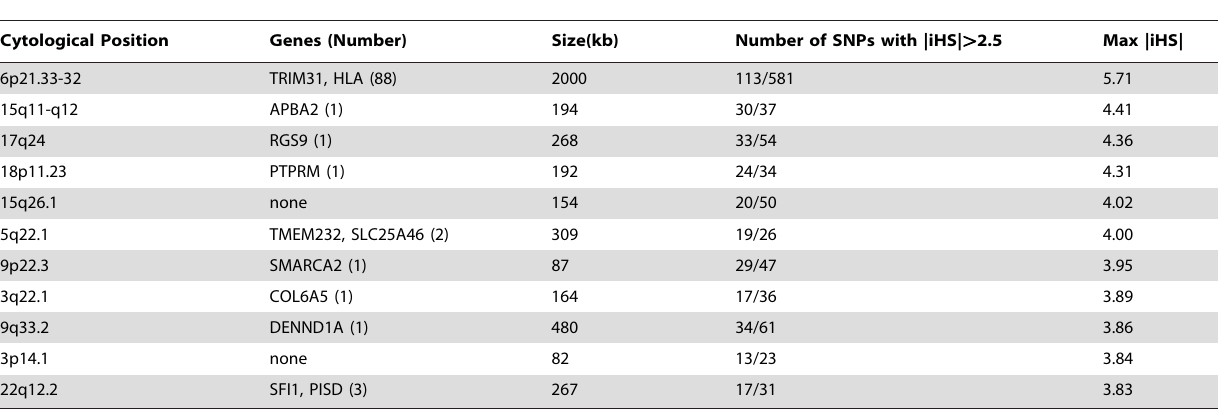
Table 1. Regions showing strongest evidence of recent positive selection in the European component.